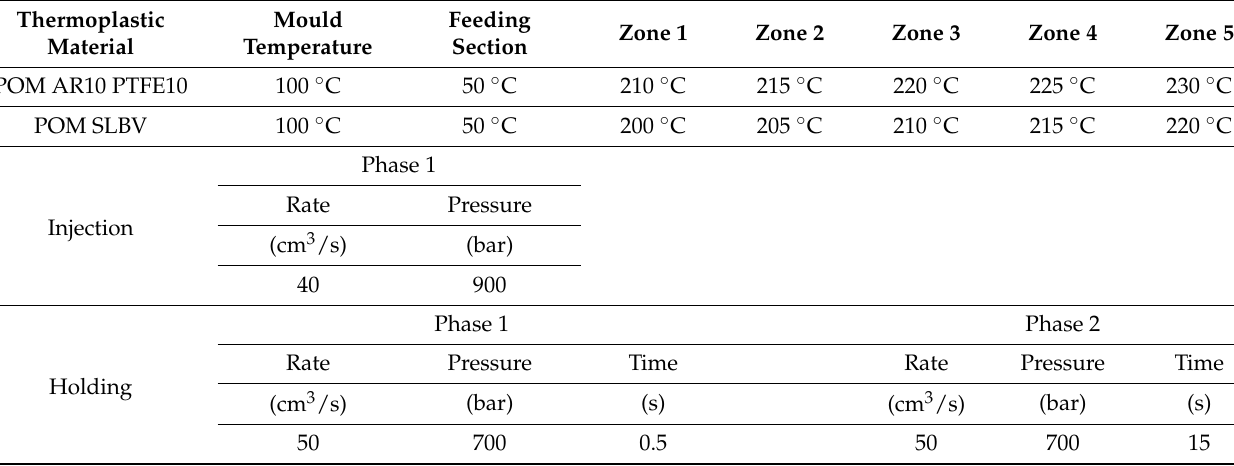
Table 3. Parameters used for overmoulding process.